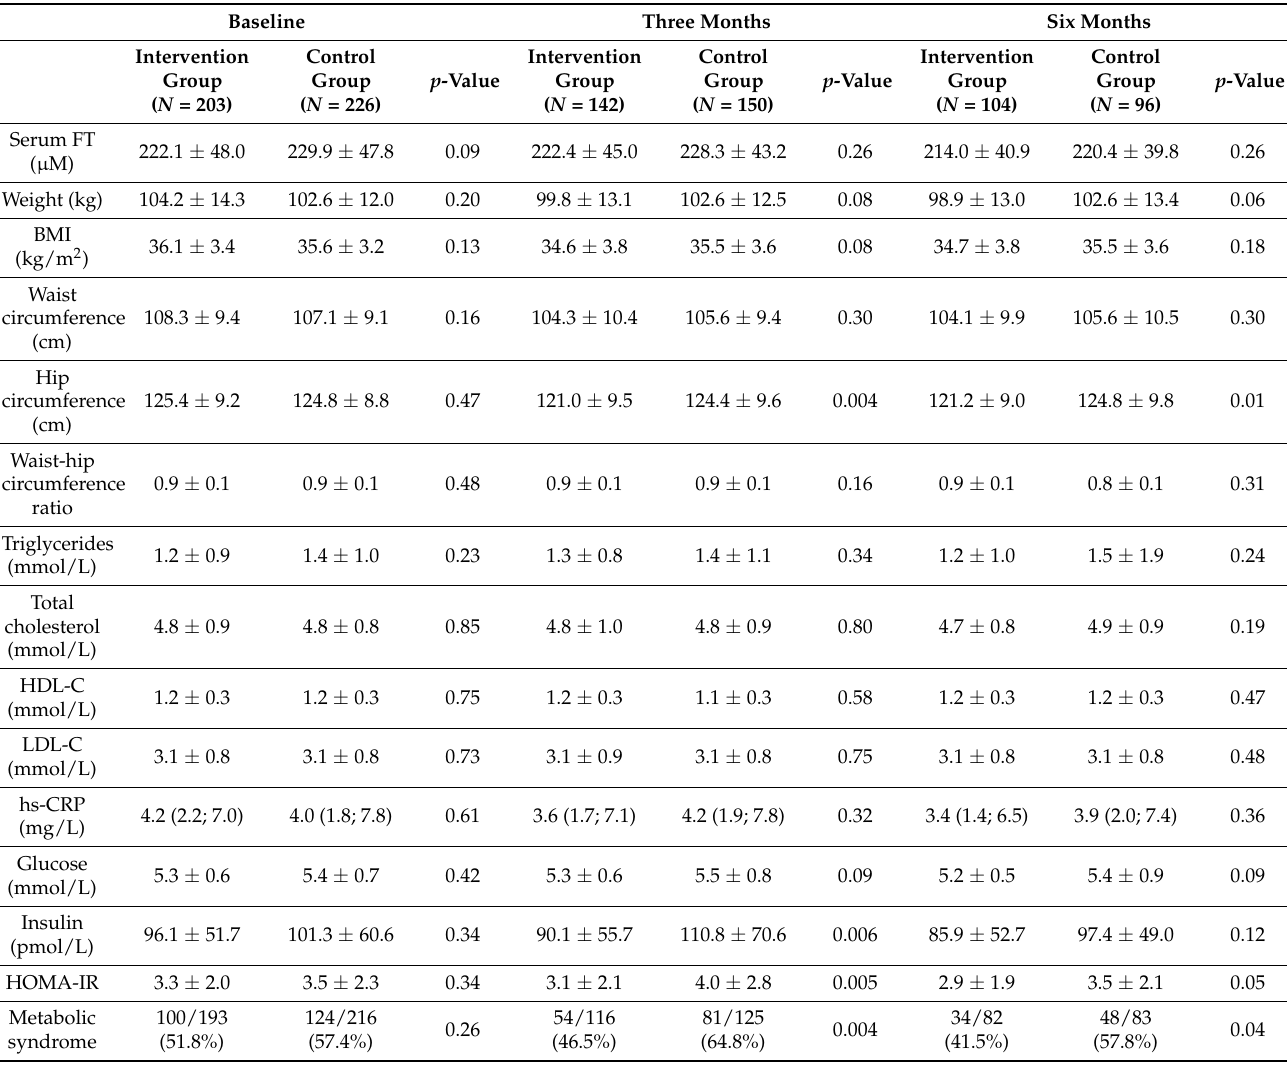
Table 2. Serum FT levels and cardiometabolic outcomes at baseline, at three months, and at six months after randomization. Baseline Three Months Six Months Intervention